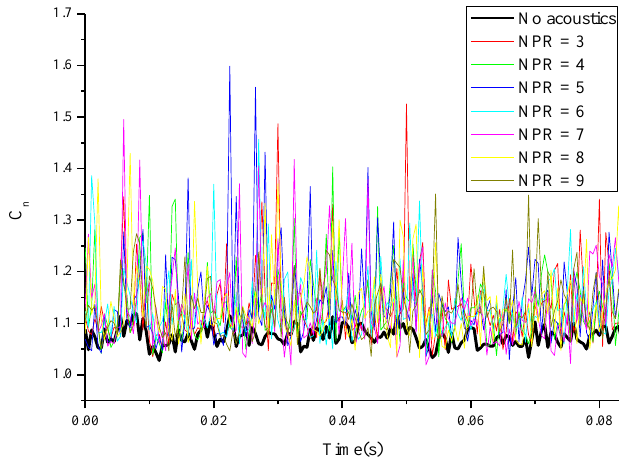
Figure 10. Variation of C n with time for cases with and without acoustics at different NPR.